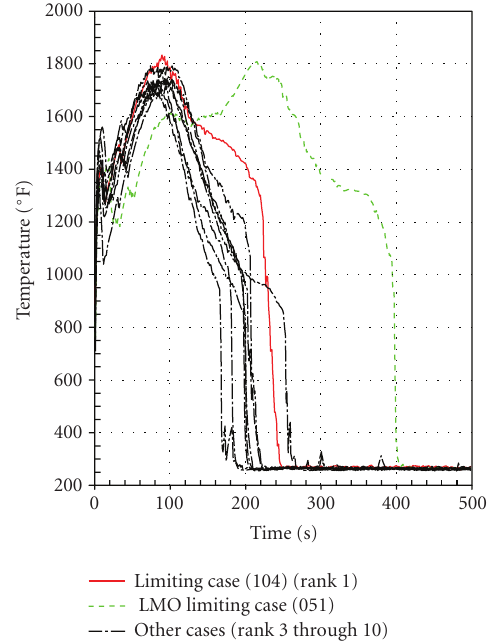
Figure 9: Clad temperature traces at the PCT elevation for the top 10 ranked PCT cases in the ASTRUM 124 run